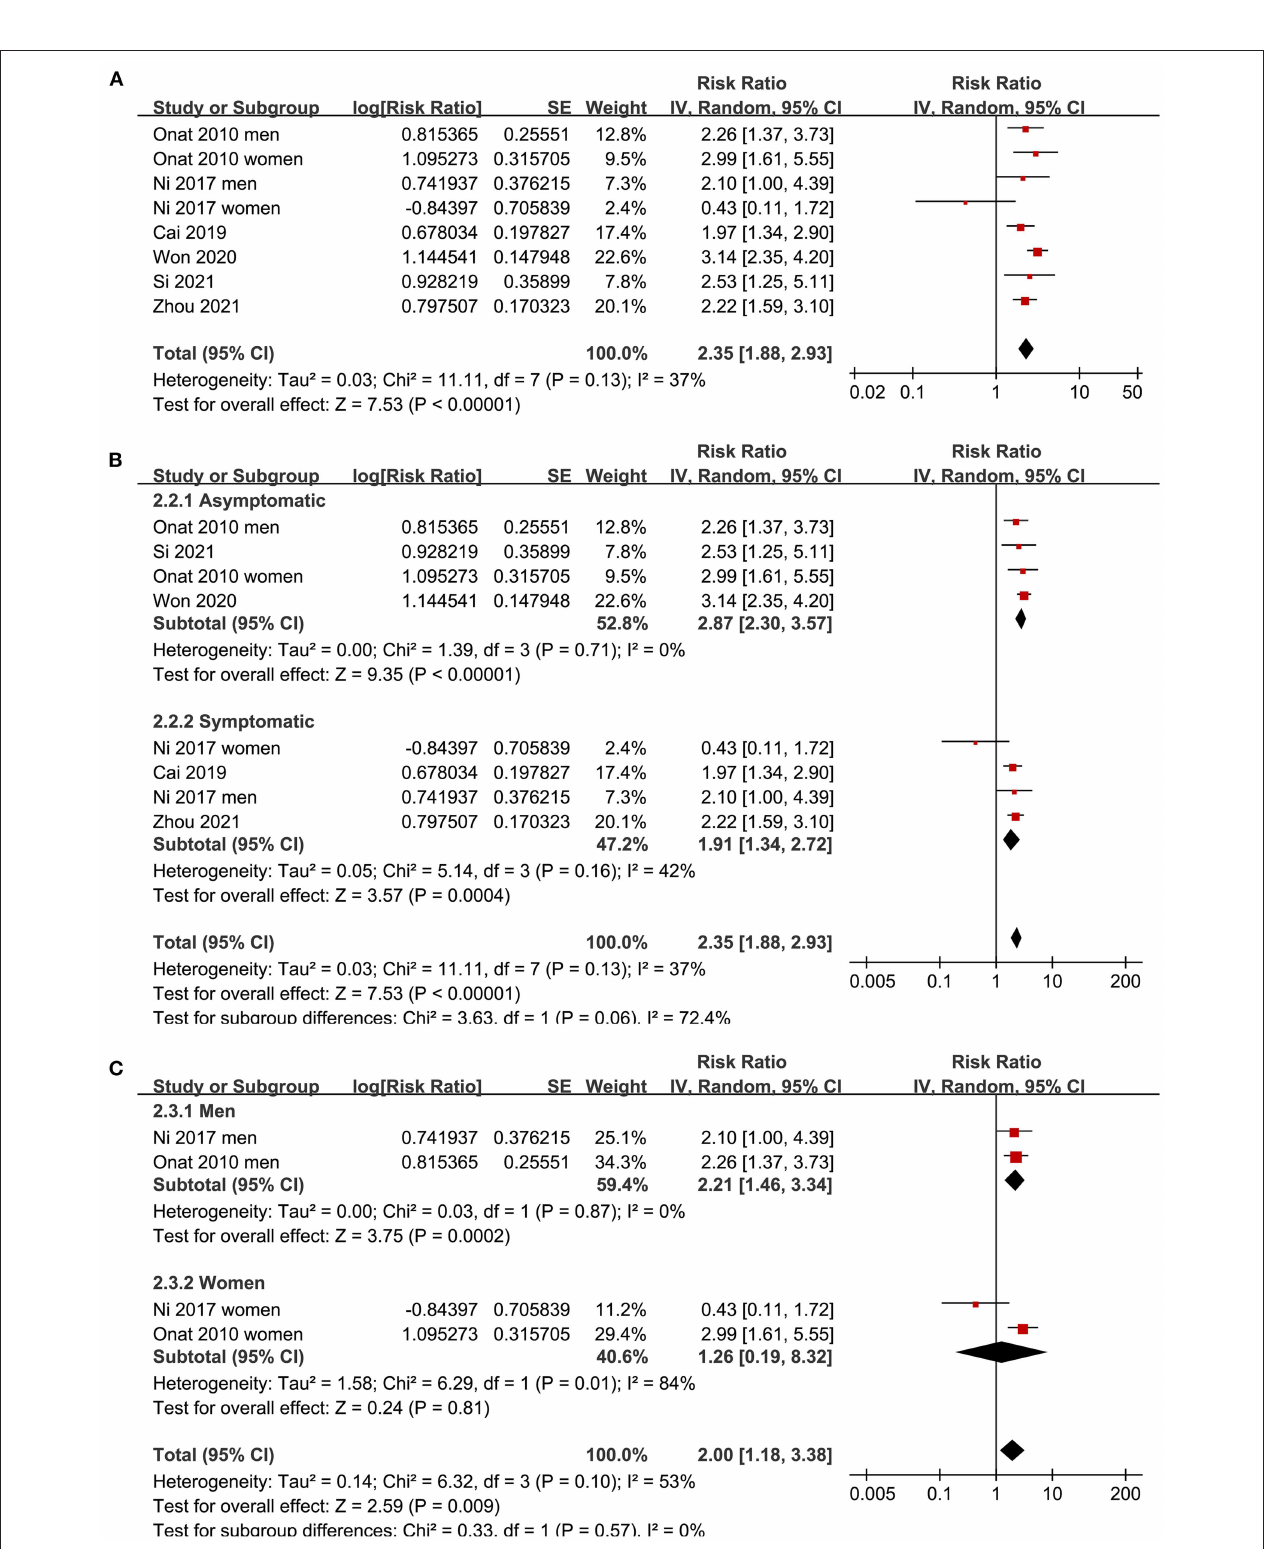
FIGURE 3 | Forest plots for the meta-analysis of the association between the AIP analyzed as a categorical variable and the odds of CAD in the adult population. (A) Overall meta-analysis; (B) Subgroup analysis according to the health status of the participants; and (C) Subgroup analysis according to the sex of the participants.